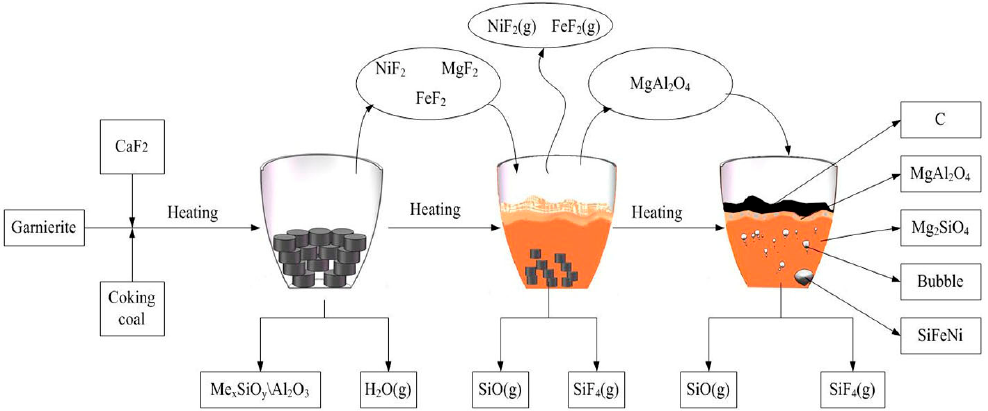
Figure 19. The influence and behavior of CaF 2 on the reduction process.